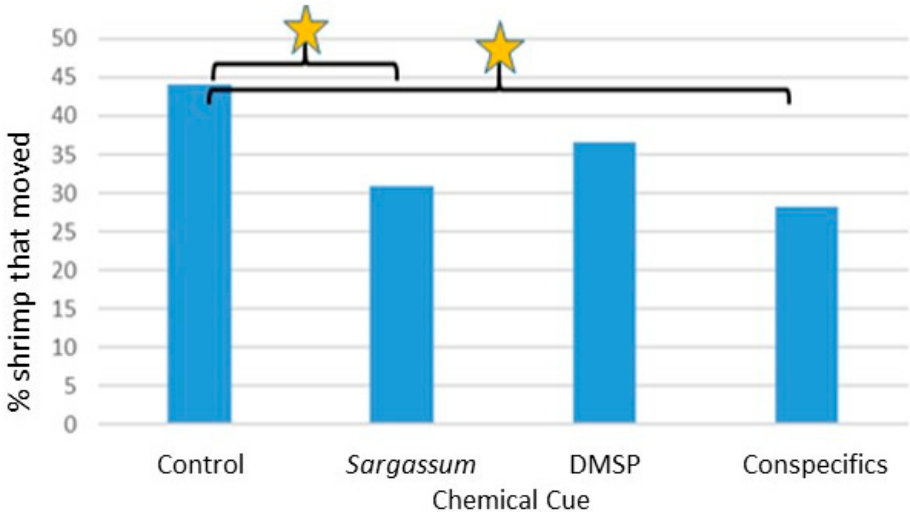
Figure 4. Number of Latreutes fucorum shrimp that moved out of area C in the Y-maze for the control, Sargassum , DMSP 10-5 M, DMSP 10-9 M, and conspecific cue trials (binomial test; Sargassum , p = 0.03; DMSP 10-5 M, p = 0.05; DMSP 10-9 M, p = 0.01; and conspecifics, p = 0.08). Star/bracket indicates significant differences between indicated paired groups.